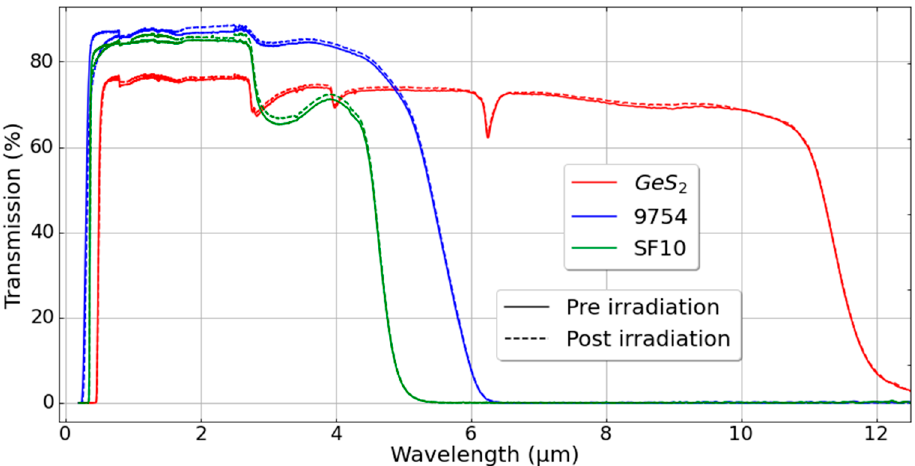
Figure 3. Optical transmission of the studied glasses before and after a π rad phase variation was implemented using FLDW. Laser parameters: 1030 nm, 800 fs, 100 kHz, 1 mm/s, 0.6 NA.